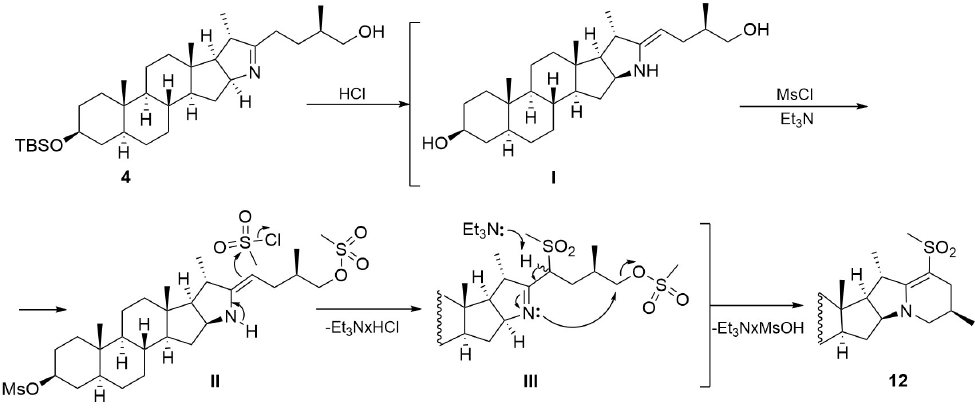
Scheme 5. Tentative mechanism of sulfone 12 formation from imine 4